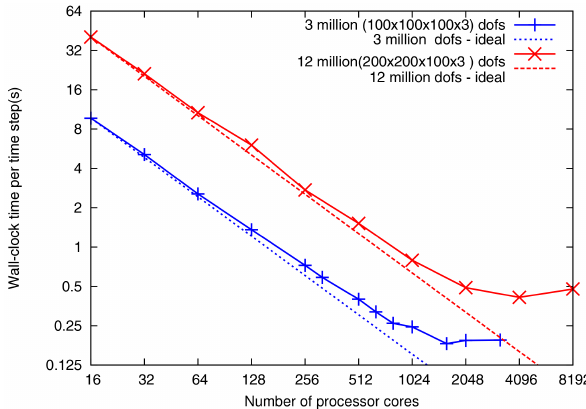
Figure 1. Strong scaling performance of PFLOTRAN using Jaguar Cray XK6 supercomputer at Oak Ridge National Laboratory for the non-isothermal, multi-phase (ice, vapor and liquid) sub-surface water flow problem (no I/O). Domain sizes with 3million and 12million dofs are considered. For the 3 million dofs case, the code scales up to 1024 processor cores with about 2929 dofs per proces- sor core, and for the 12million dofs case, it scales up to processor cores with approximately 5850 dofs per processor